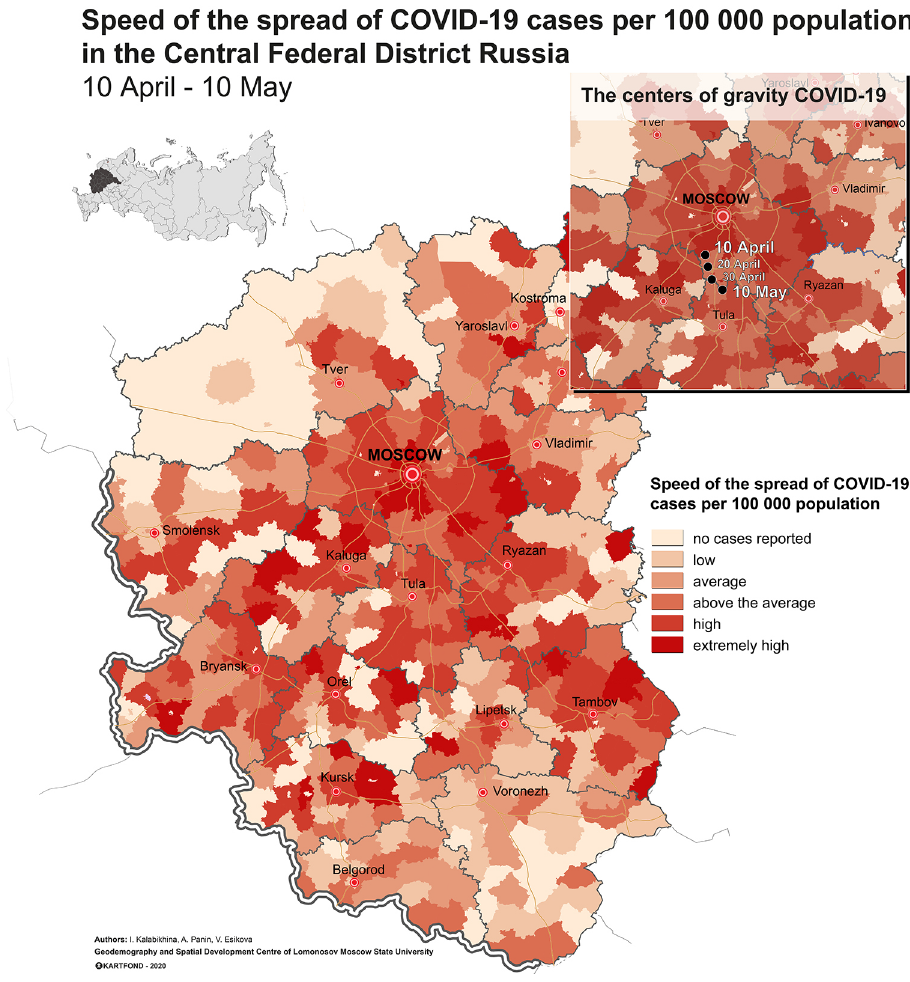
Figure 19. Speed of the spread of COVID­19 cases per 100 thousand population in the municipali­ ties of the Central Federal District of Russia, 10.04.2020 – 10.05.2020, according to Rospotrebnadzor (2020). Source: Compiled by the researchers of the Geodemography and Spatial Development Centre of the Population Department of the Economics Faculty of Lomonosov Moscow State University to­ gether with the “Kartfond” research group. Note: No cases reported: ­0.500000 – 0.000000 (cases per 100 000 population per month); low: 0.000001 – 0.150000; average: 0.150001 – 0.300000; above the average: 0.300001 – 0.600000; high: 0.600001 – 1.200000; extremely high: 1.200001 –